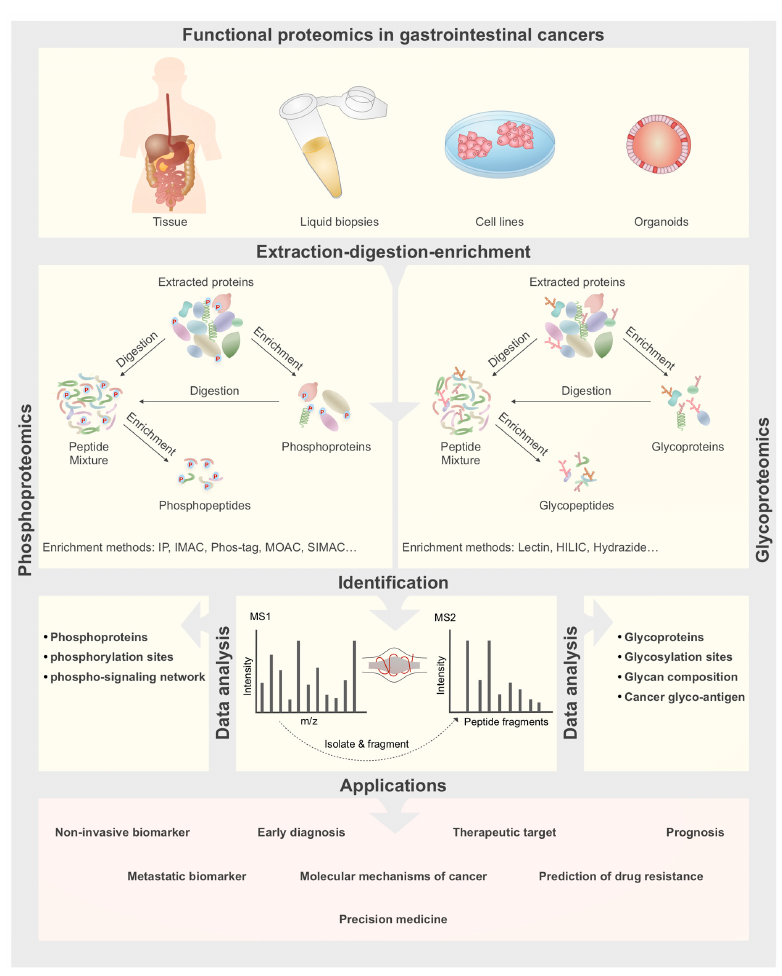
Figure 1. General workflow for functional proteomics analyses in gastrointestinal (GI) cancers. Samples can be obtained from patient’s tumor biopsies, body fluids, cultured cell models or patient-